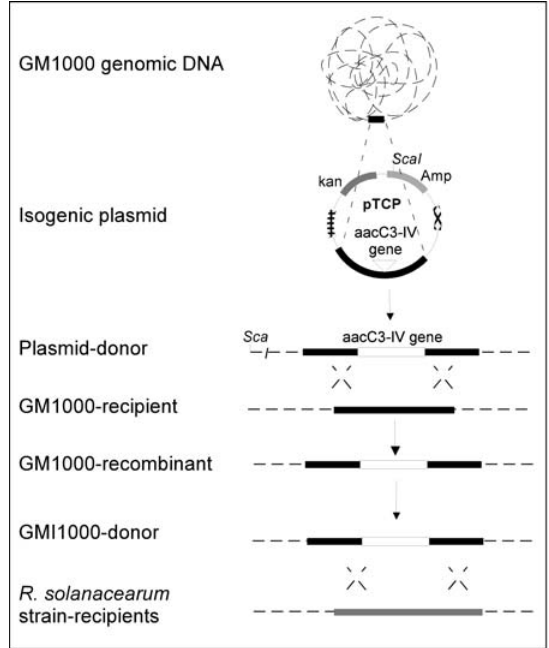
Figure 1. Experimental design to measure recombination rate at different positions of the R. solanacearum chromosome. Target positions on the chromosome (TCP) and on the megaplasmid (TMP) were identified and amplified by PCR. PCR products from the different genomic positions were cloned in appropriate vectors and afterwards, labeled with the aacC3-IV gene (gentamycin cassette). The pTCP (versus pTMP) plasmid carrying homologous GMI1000 fragments were linearized and resulting plasmids were used as donor to transform naturally the wild type strain GM1000 and recombination rate of each position designed. Total genomic DNA from R. solanacearum transfor- mants and carrying aacC3-IV cassette resulting from double crossing- over were used as exogenous DNA donor to ‘‘re-transform’’ the wild type strain GM1000 and the CFBP2968, NCPPB332 and CFBP2957 strains to determine the recombination rate of genomic DNA. (Amp, ampicillin and Kn, kanamycin).